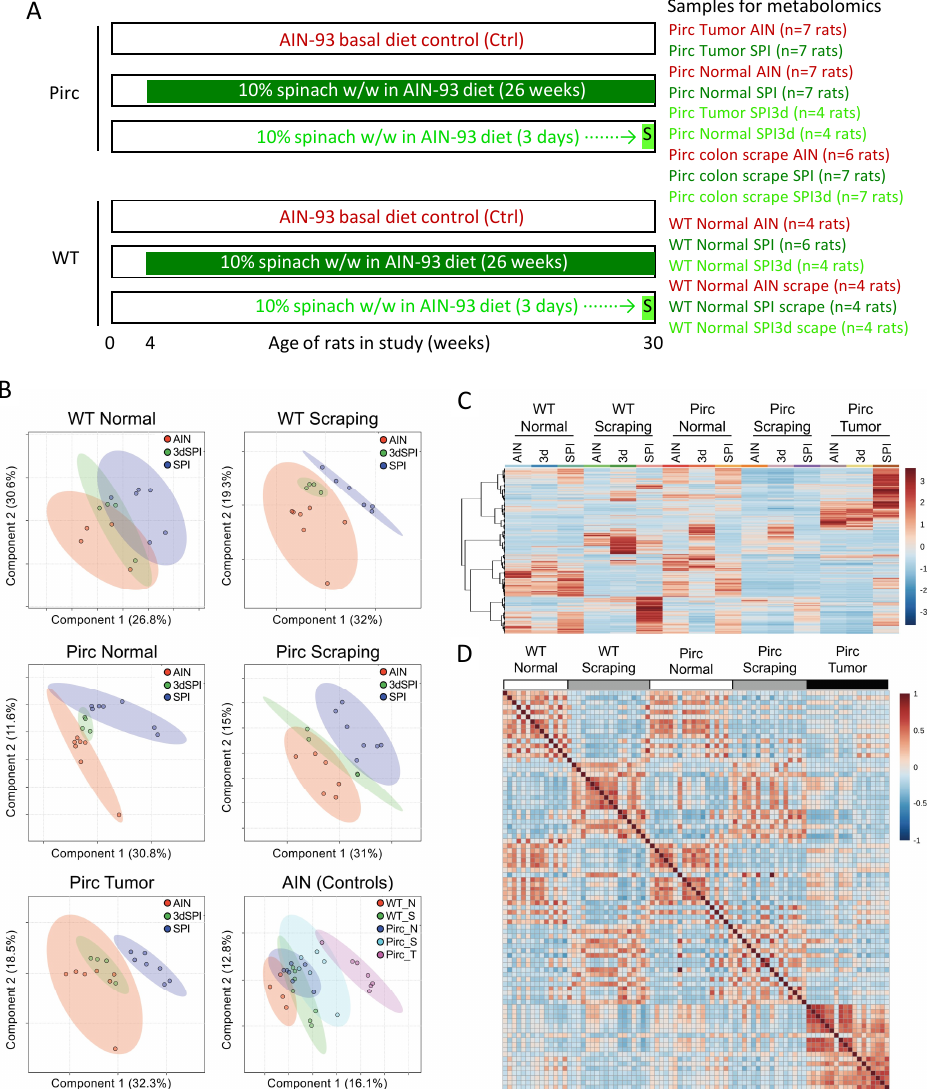
Figure 1. Dosing scheme and metabolomic analyses in Pirc and wild–type (WT) rats. ( A ) Animals were given AIN basal diet or AIN diet containing 10% spinach ( w / w ) for 26 weeks (SPI) or for 3 days (SPI3d). At necropsy, adenomatous colon polyps, normal colon ‘punch’ biopsies, and colonic mucosa scrapings were collected. ( B ) Partial least squares discriminant analysis of 17,243 metabolomic features. ( C ) Heatmap of 5946 hierarchically clustered significant features, representing the average of each group and auto–scaled by feature. ( D ) Correlation analysis across tissue